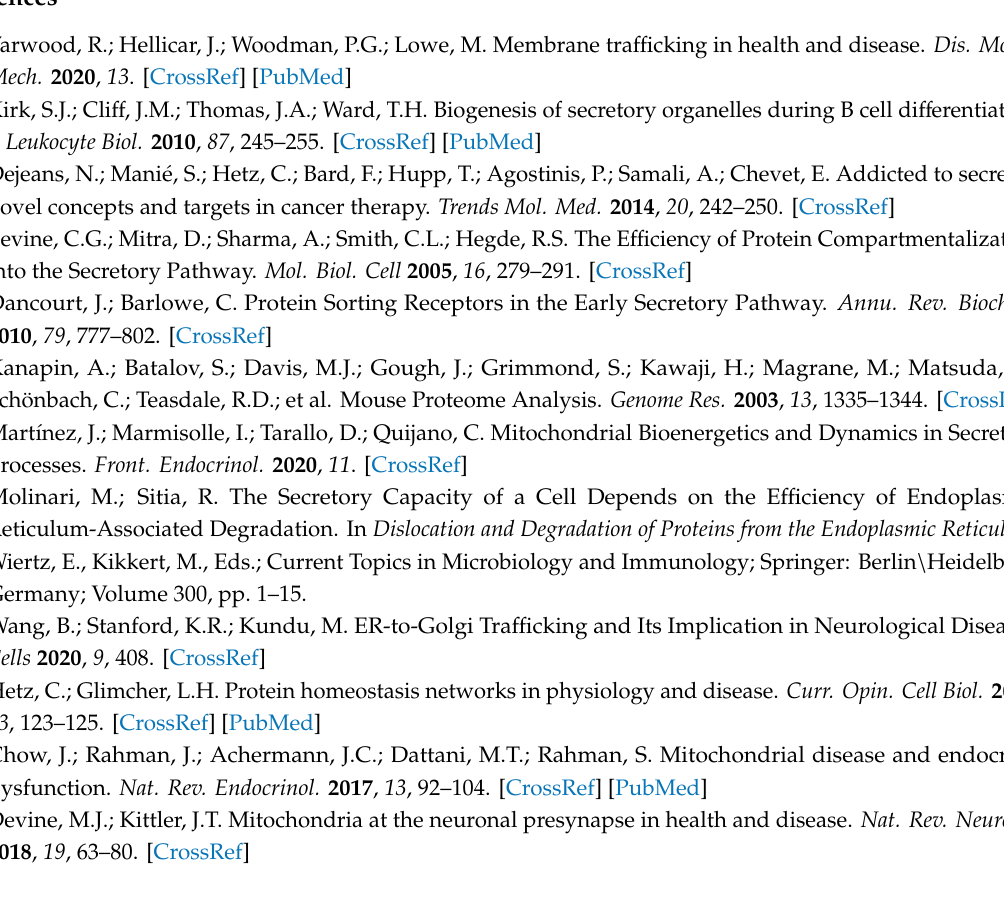
Figure S5: ER-morphology is not changed upon short-term energy stress in HeLa cells, Figure S6: Severe energy depletion via 2-DG does not a ff ect the microtubule network in HeLa cells, Figure S7: Induction of severe energy stress does not impair disaggregation of CAD-containing cargo constructs, Figure S8: ER-to-Golgi transport of transmembrane cargo in HeLa cells over 30 min, Video S1: Vesicle movement in HeLa cells treated with glucose-containing bu ff er, Video S2: Vesicle movement in HeLa cells treated with 2-DG-containing bu ff er, Video S3: Vesicle movement in HeLa cells after Ca 2 + -mobilization with bu ff er containing no Ca 2 + and 0.1 mM EGTA, Video S4: Vesicle movement in HeLa cells after Ca 2 + -mobilization with bu ff er containing 2 mM Ca 2 +